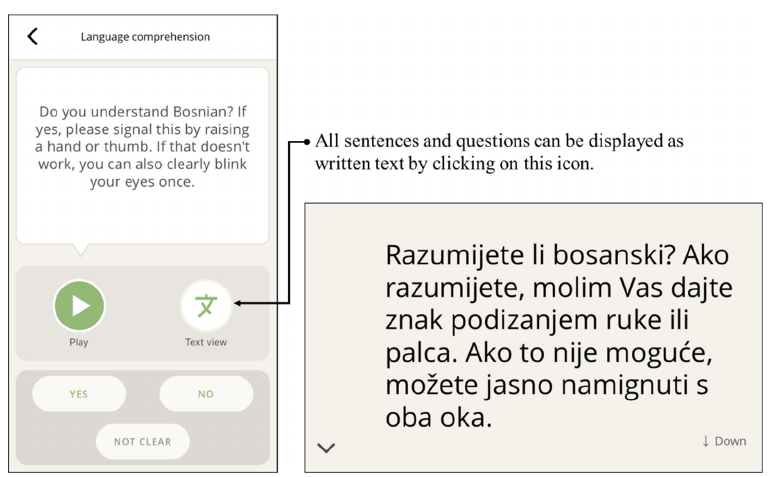
Figure 3. Language comprehension can be checked in the first step (here in Bosnian: “Do you un- derstand Bosnian? If yes, please signal this by raising a hand or thumb. If that doesn’t work, you can also clearly blink your eyes once.”). The phrases can be played back audibly or displayed as